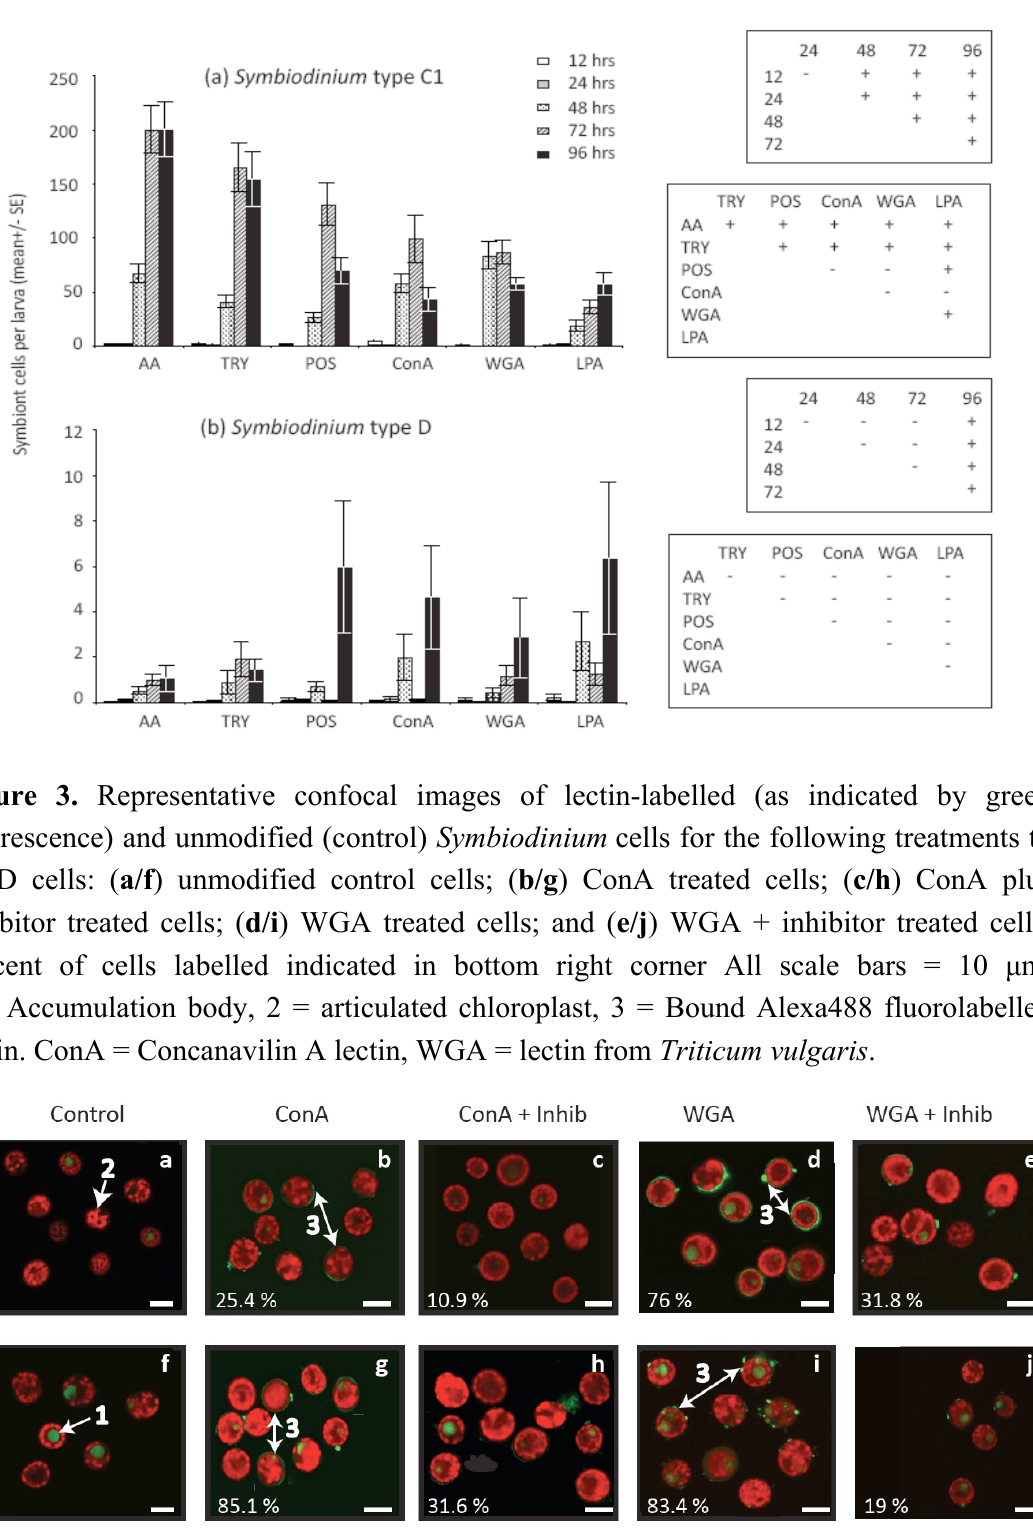
Figure 2. Mean number of ( a ) C1 and ( b ) D Symbiodinium cells per larva (n = 45). Statistical significance of pairwise post-hoc comparisons among sampling times and cell surface treatments are presented in boxes (+ indicates significance at α = 0.05). AA = α -Amylase, TRY = Trypsin, POS = Positive unmodified control, ConA = Concanavilin A lectin from Jack bean, LPA = lectin from Limulus polyphemus , WGA = lectin from Triticum vulgaris .